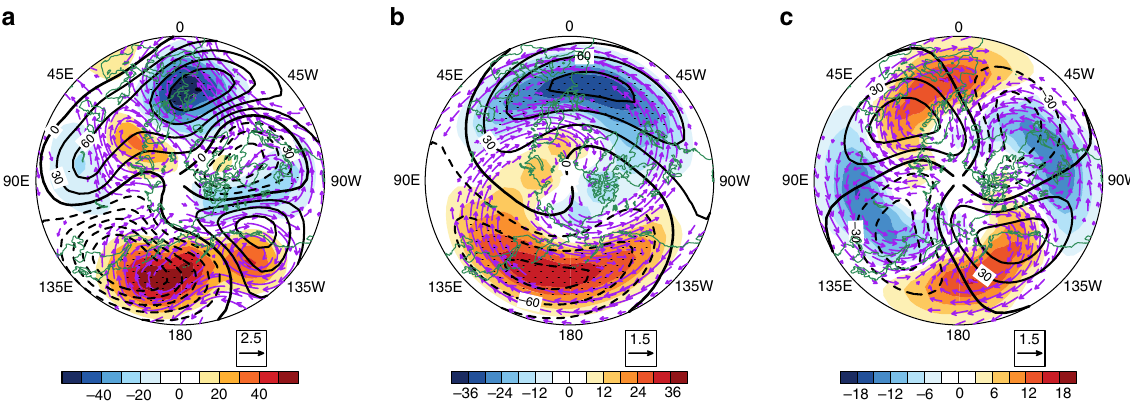
Fig. 3 Trends in the wave activity. The trends in the geopotential height (shading; units: gpm decade − 1 ) and winds (vectors; m s − 1 decade − 1 ; only values above 1.0 m s − 1 decade − 1 are shown) at 500 hPa using MERRA during December – January – February over 1997/98 – 2015/16 ( a ). b , c As in a , but for b wavenumber-1 and c wavenumber-2 components. The black contours indicate the mean climatology of the 500-hPa geopotential height. The stippled areas show the trends signi fi cant at/above the 95% con fi dence